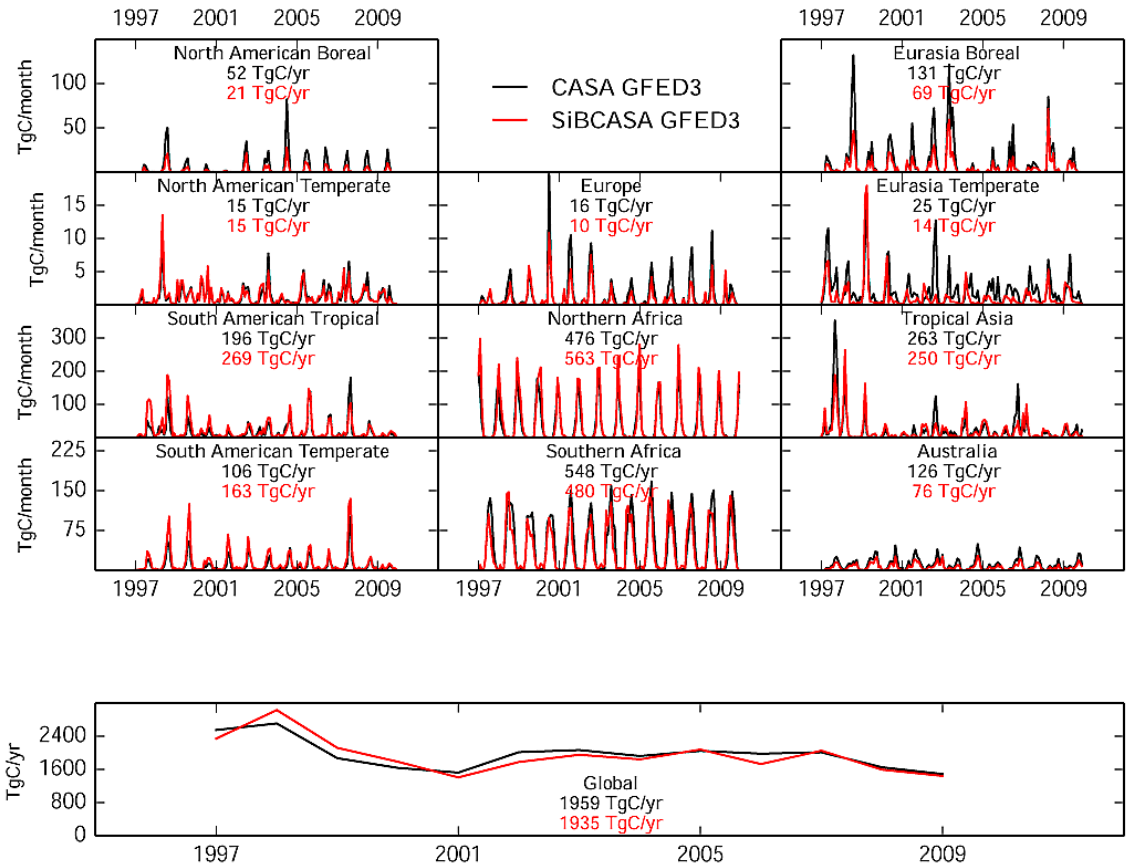
Figure 4. Monthly fire emissions (TgCmonth − 1 ) over 1997–2009 for 11 different TransCom regions. CASA-GFED3 (black) is compared to SiBCASA-GFED3 (red) estimates. The multi-year averages for each region are given as values in TgCyr − 1 . The regions are geographically ordered, with North American boreal in the top-left panel and Australia in the lower-right panel. Horizontally, the panels share the same y axis. The global annual fire emissions (TgCyr − 1 ) for both simulations are displayed in the separate panel